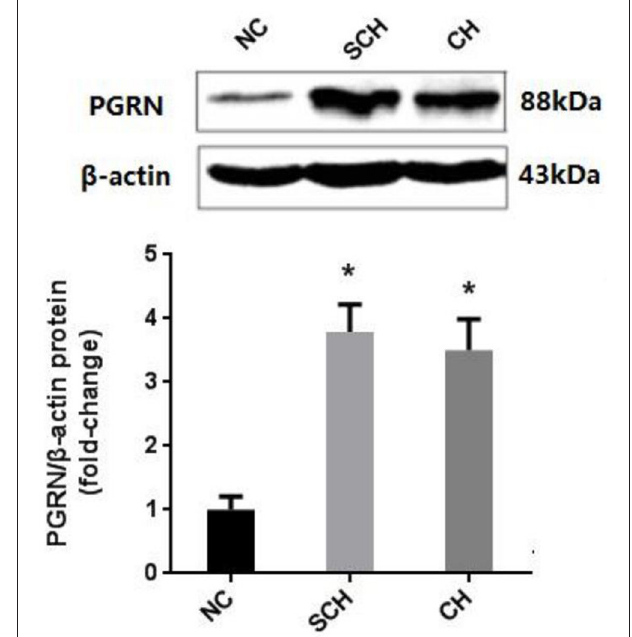
FIGURE 1 | Expressions of eNOS in the aorta of the three groups. Protein samples were extracted from the aorta in rats of NC, SCH, and CH groups. N = 10 in each group. Error bars represent mean ± SEM; * P < 0.05, when compared with the NC group.